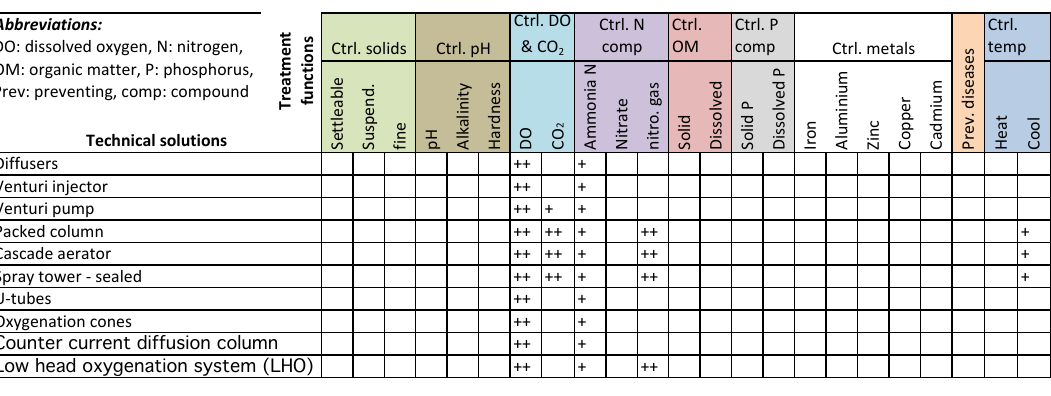
Table 4. QFD matrix presenting how dissolved oxygen and CO 2 control methods influence different treatment